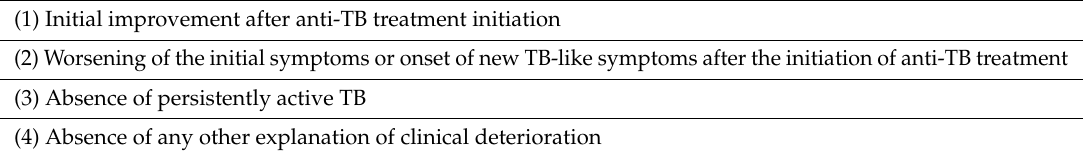
Table 1. Diagnosis of immune reconstitution inflammatory syndrome (IRIS) with fulfilment of the four following criteria. TB: